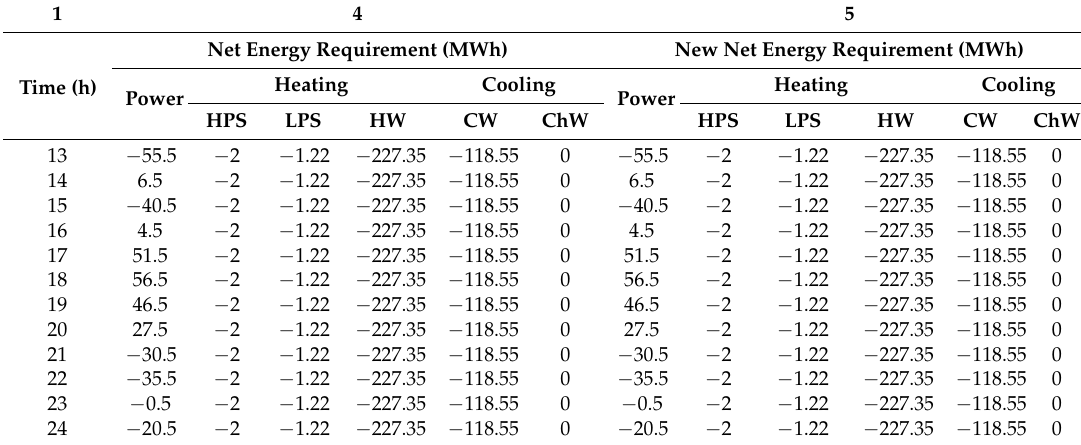
Table A4. TriGenSCA before iteration from time 13 to 24 h.